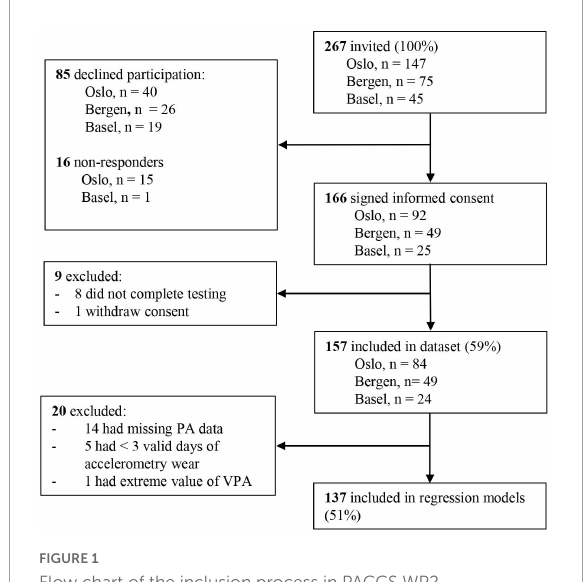
FIGURE1 Flow chart of the inclusion process in PACCS WP2.